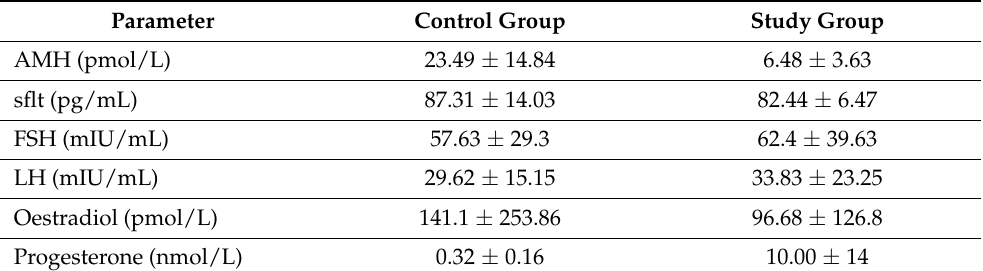
Table 2. Biochemical analysis of the blood samples collected from 29 patients (both the control and study groups). Data expressed as mean ±